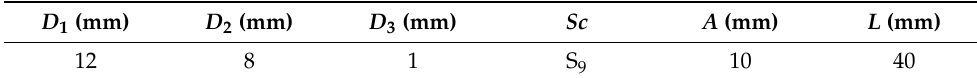
Table 4. Parameters of commercial product nozzle.